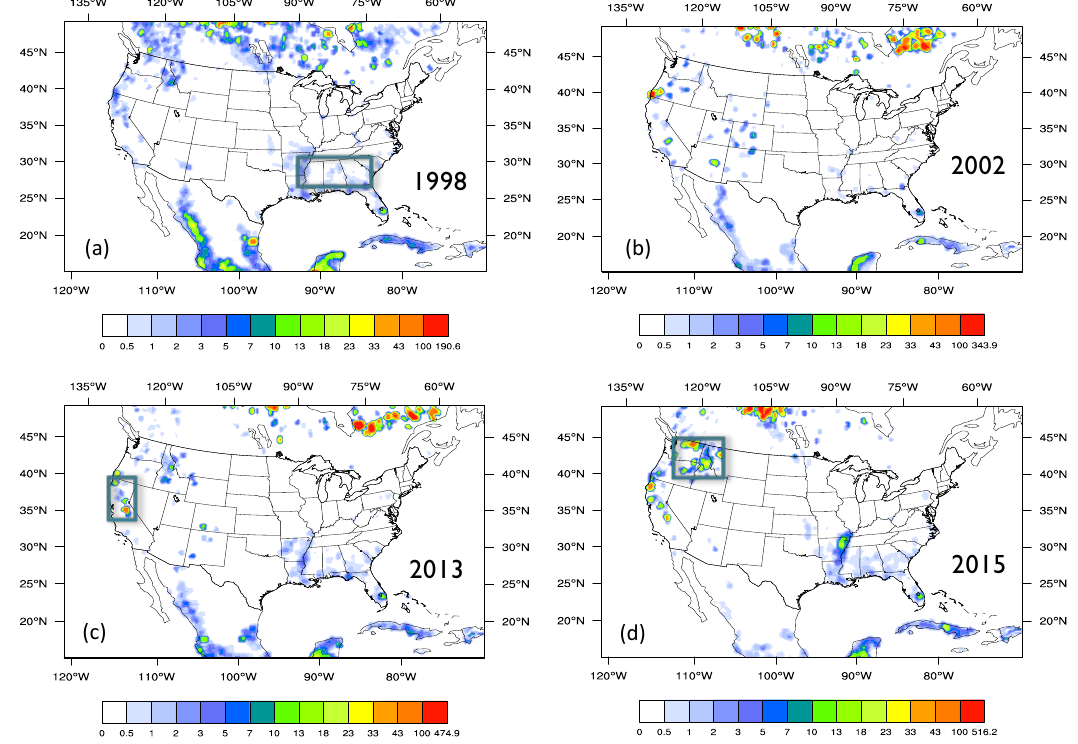
Figure 2. Spatial distributions of fire CO emissions (tons km − 2 yr − 1 ) for 1998, 2002, 2013, and 2015. Boxes over the maps represent the sub-regions subject to further analysis–southeastern U.S.; Northern California, and northwestern